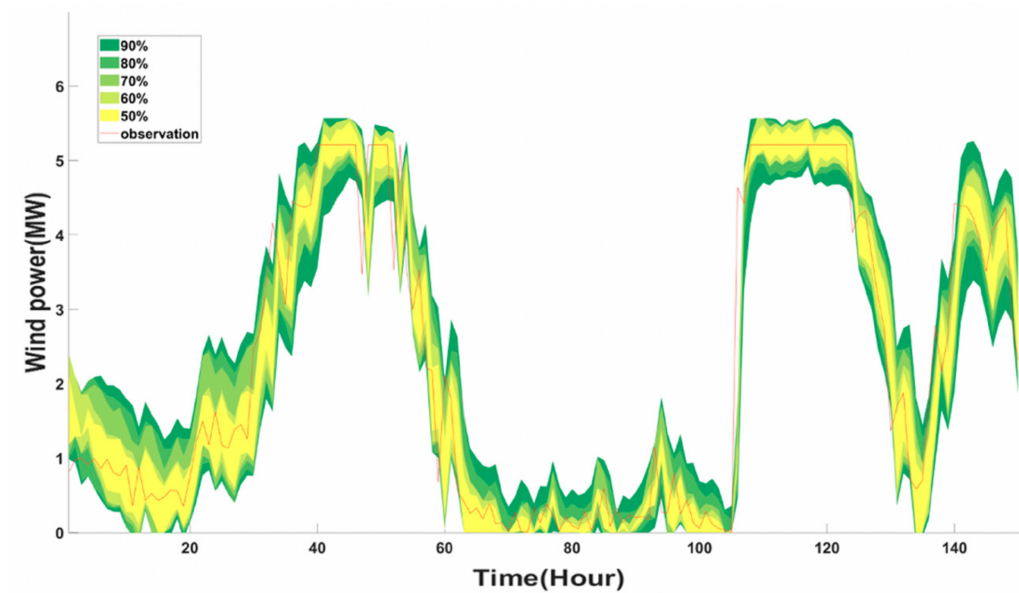
Figure 13. Three-h-ahead probabilistic forecasting results by Method 1a (RWRF, WEPS).